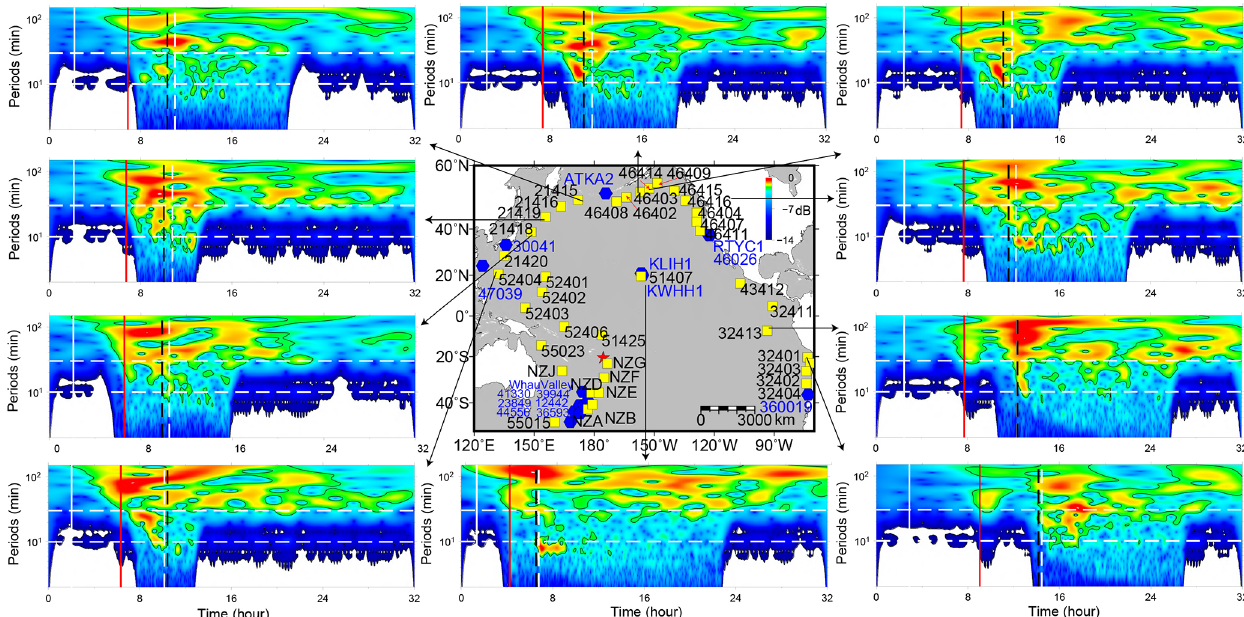
Figure 6. Wavelet analysis of representative DART buoys far away from the HTHH volcano. In each subplot, the solid vertical white lines mark the arrival time with a travelling velocity of 1000ms − 1 . The solid vertical red lines mark the arrivals of Lamb waves. The dashed vertical white lines mark the lower limit of AGWs’ velocity of 200ms − 1 . The dashed vertical black lines represent the theoretical tsunami arrivals. The dashed horizontal white lines mark two reference wave periods of 10 and 30min. The blue hexagons represent the locations of